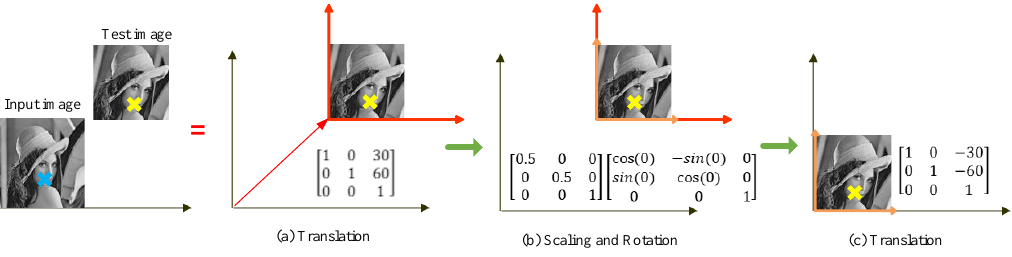
Figure 7. Illustration of the FBRLF orientation assignment.